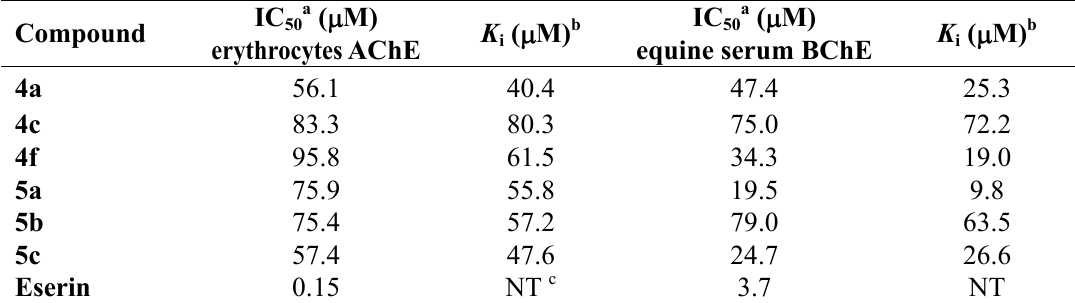
Table 2. Inhibitory effects of selected sulfonamide chalcones on the cholinesterases AChE and